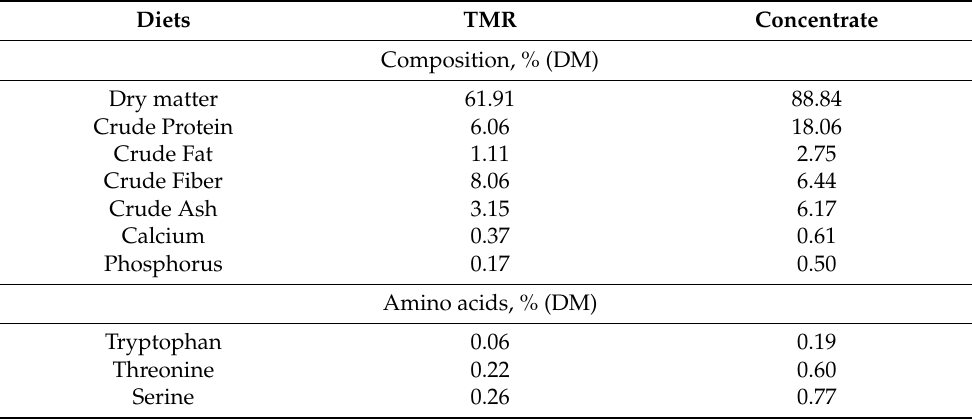
Table 1. Analyses of chemical compositions and amino acid profile of experimental